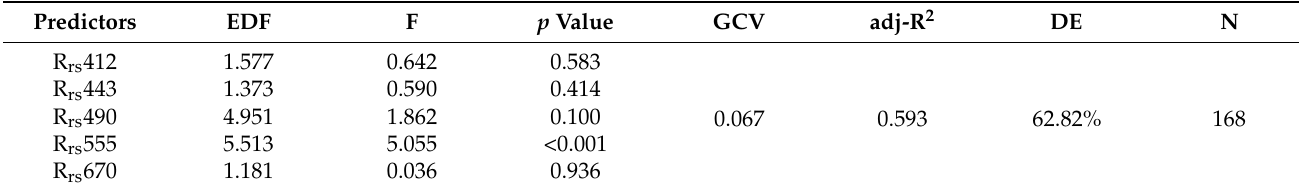
Table 9. Statistical summary of the fitted prymnesiophytes GAM.